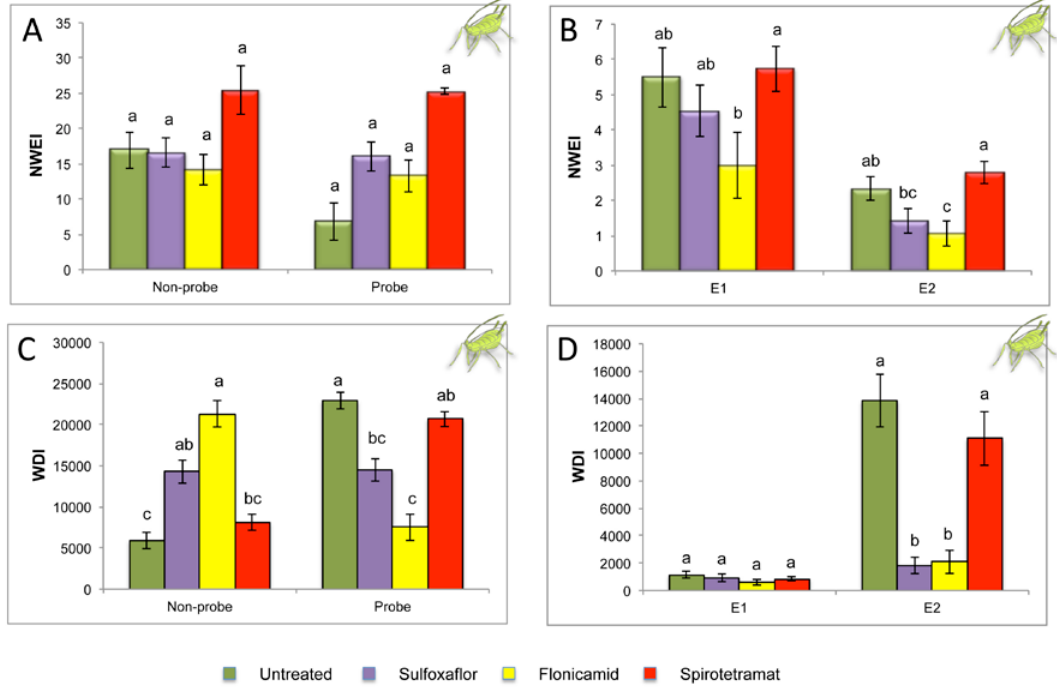
Figure 3. Nonsequential EPG variables (mean ± SE) for aphids exposed to Physallis floridana treated with systemic insecticides (sulfoxaflor, flonicamid, and spirotetramat) and to untreated plants. ( A , B ) Number of waveform events per insect (NWEI); ( C , D ) Waveform duration per insect (WDI; time expressed in seconds). Waveform nonprobe, no stylet contacts with leaf tissue; Probe, all activities into plant tissue in which stylets were involved (Waveforms C, pds, F, G, E1, and E2); Waveform E1, salivation in sieve element; Waveform E2, passive phloem sap uptake from sieve elements. Mean values followed by di ff erent letters were significantly di ff erent ( P ≤ 0.05) according to Dunn’s test with Bonferroni